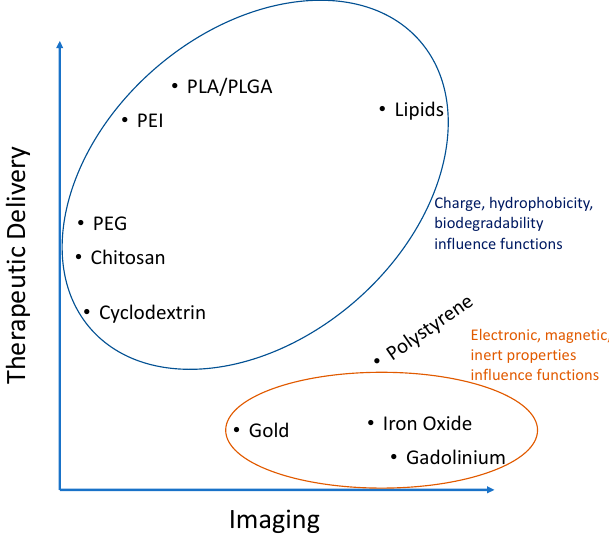
Figure 2. Analysis of Table 1 showing importance of the characteristics of certain materials used to fabricate nanoparticles for atherosclerosis research.